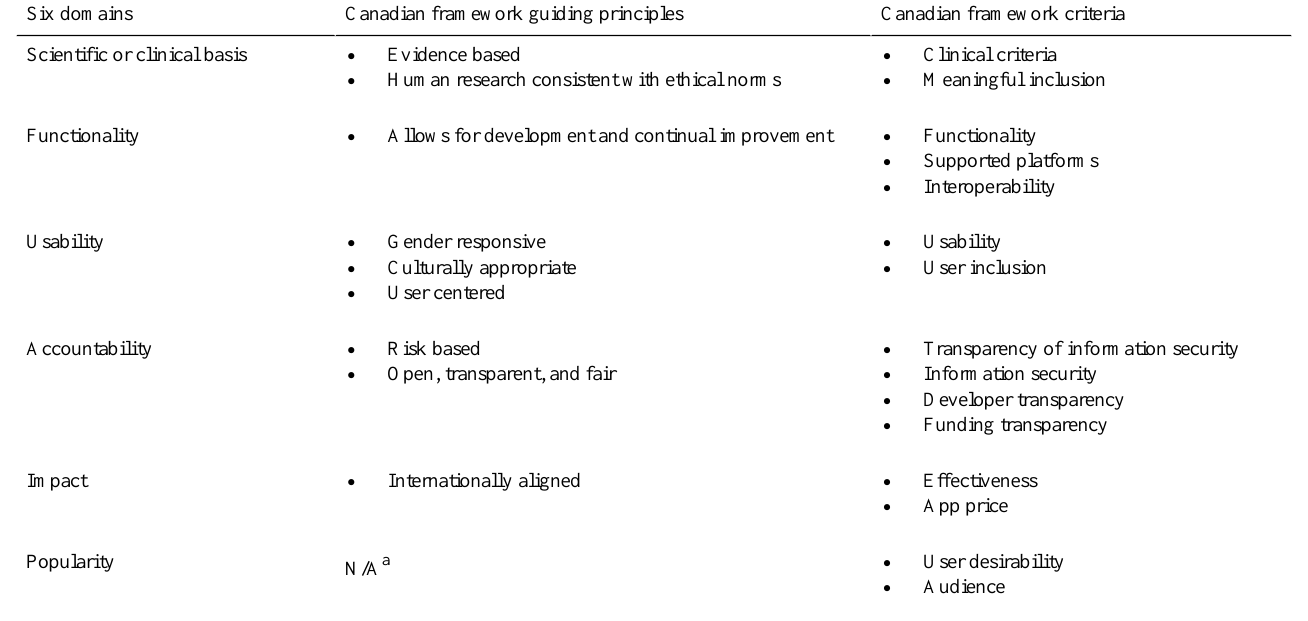
Canadian framework criteriaCanadian framework guiding principlesSix domains